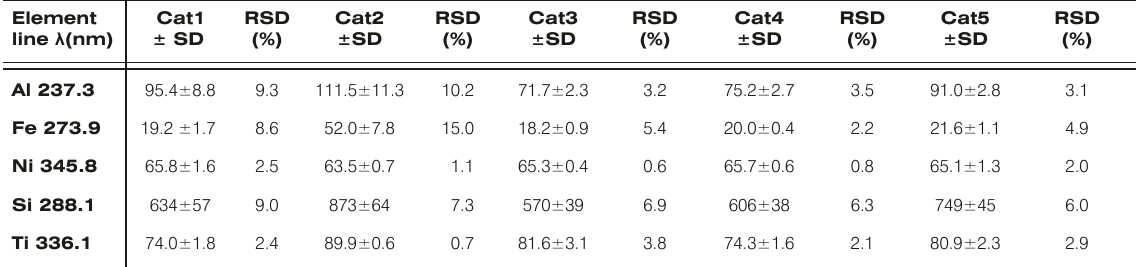
Table 4. Results of the real catalysts samples Cat1 – Cat5, and precision control expressed as RSD (%) of the repeated measurements (presented the intensity values ± standard deviation of the measurements of real catalysts samples Cat1 – Cat5). Element line λ